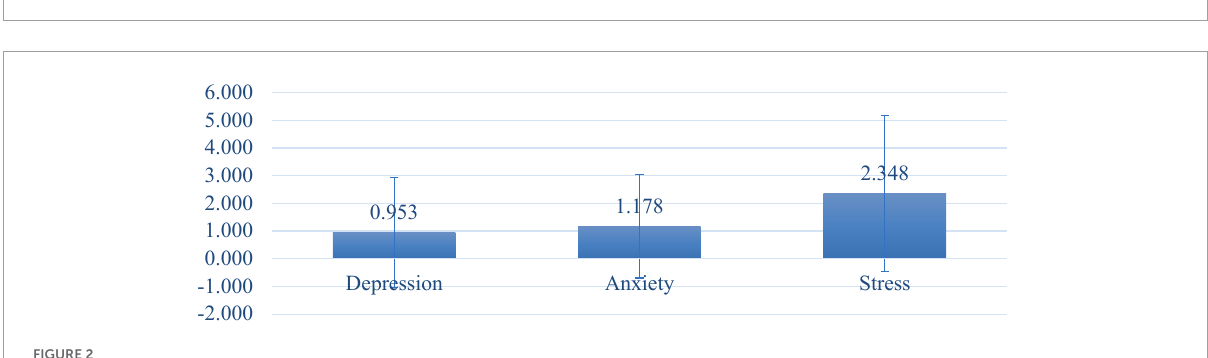
FIGURE1 Levels of depression, anxiety, and stress among study participants.